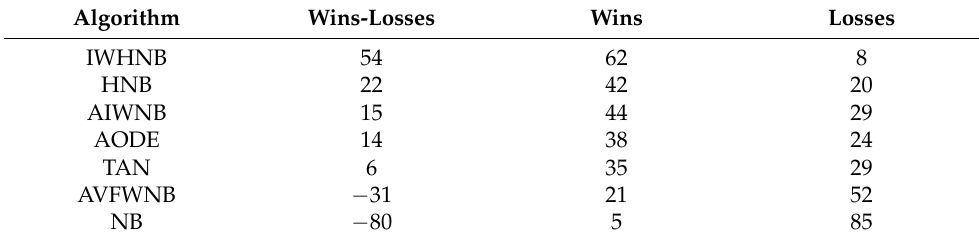
Table 3. Ranking test results on classification